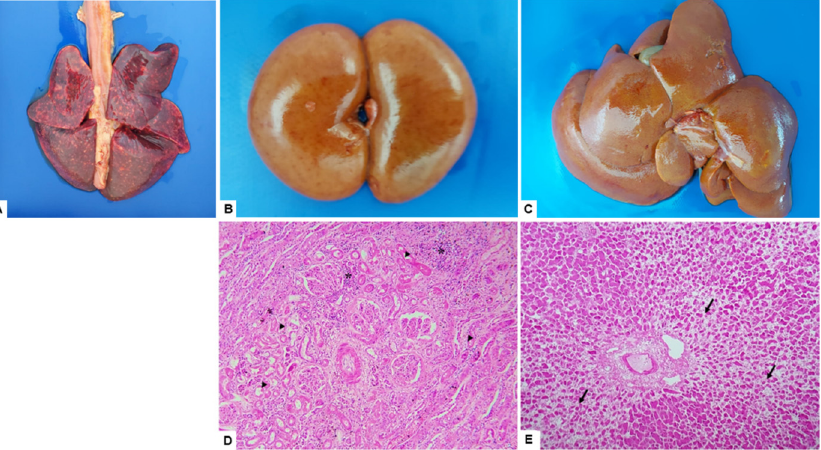
Figure 1. Common gross and histopathological findings of the infected dog. Necropsy findings included generalized icterus, petechial to ecchymotic hemorrhages in the lungs ( A ), kidneys ( B ), and liver ( C ). For histopathological analysis tissues were stained with hematoxylin and eosin (HE). Note, kidneys showing interstitial nephritis with multifocal lymphohistiocytic (asterisk) with diffuse tubular degeneration (arrowhead) ( D ), and liver with massive dystrabeculaton (loss of cohesion) of hepatocytes with degeneration areas, and necrosis (arrows) ( E ). The histopathology photomicrographs were taken at a magnification of ×10.